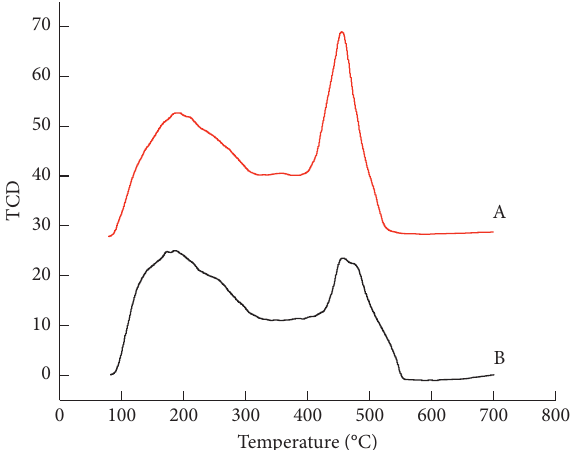
Figure 6: NH3-TPD profiles of ZSM-5 and Ni-ZSM-5 catalysts. A. Ni-ZSM-5; B. ZSM-5.